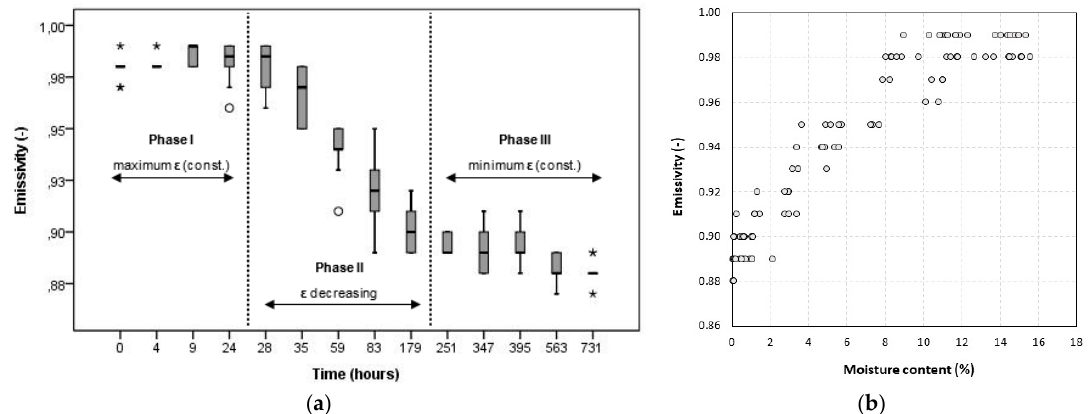
Figure 3. ( a ) Emissivity versus time; ( b ) Emissivity versus moisture content. (In both Figures, the average of three measurements for each one of the ten specimens under study was